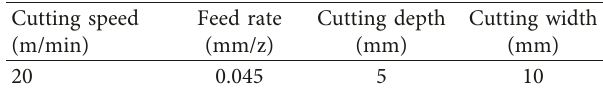
Table 3: List of the milling parameters.